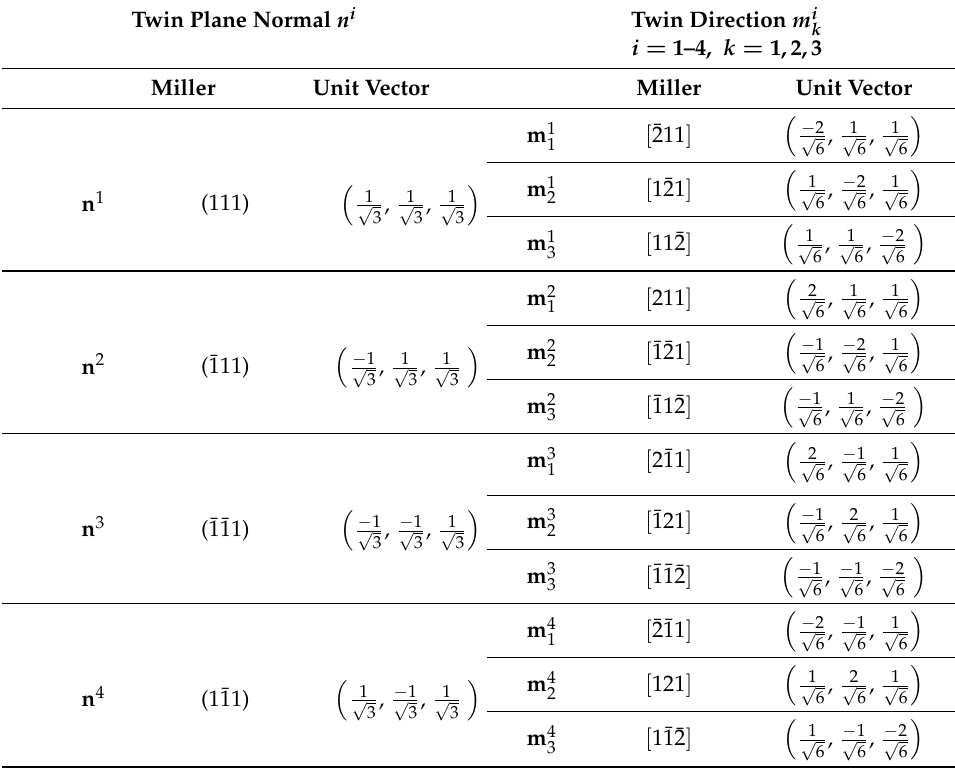
Table A2. Twin systems of FCC